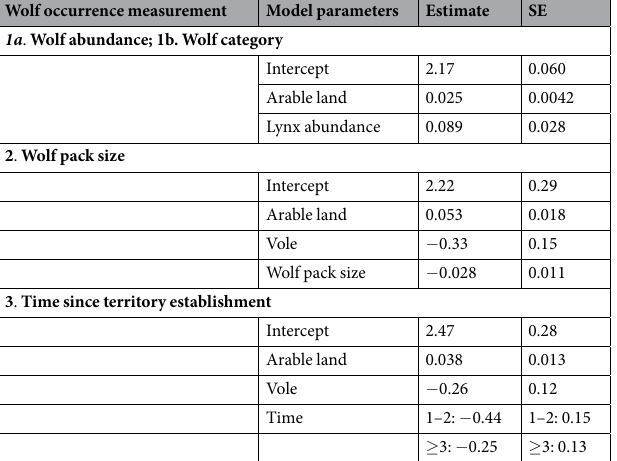
Table 2. Model-averaged parameter estimates with standard error (SE) for each variable retained in the best models ( Δ AIC c ≤ 2) in Table 1. We used four separate measurement of wolf occurrence, as defined in Table 1. Vole density index is a two-category variable where the parameter estimate is the difference in red fox abundance for low compared to high (intercept) vole density index. Time since territory establishment class is categorical, where the parameter estimate is the difference in red fox abundance at 1–2 years or ≥ 3 years after territory establishment compared to the year of establishment (intercept).